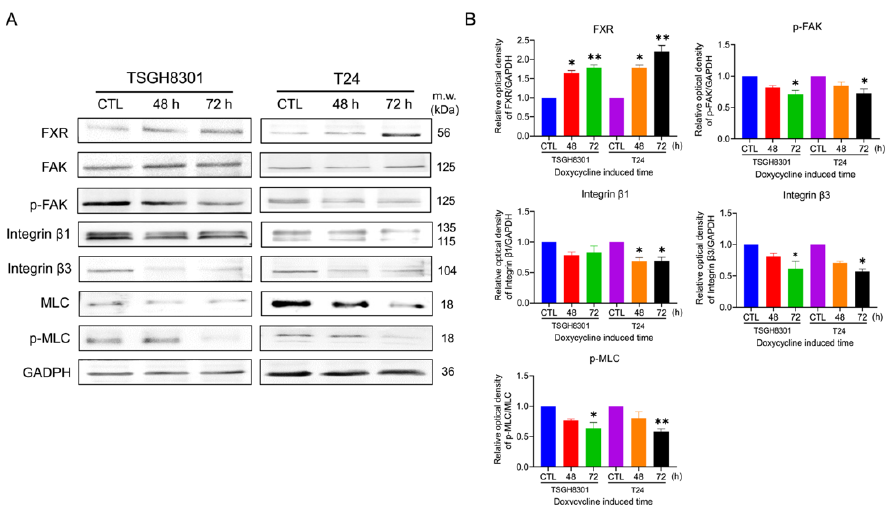
Figure 3. The effect on focal adhesion complex expression after FXR overexpression. ( A ) Focal ad- hesion kinase (FAK), phospho-focal adhesion kinase (p-FAK), integrin β1, integrin β3, myosin light chain (MLC) and phospho-myosin light chain (p-MLC) were analyzed by Western blotting in the TSGH8301 and T24 cells after FXR overexpression for 48 and 72 h. GAPDH was used as the loading control. ( B ) The bar graphs show the relative quantitative analysis of the aforementioned proteins. * p < 0.05; ** p < 0.01 compared with the control group.